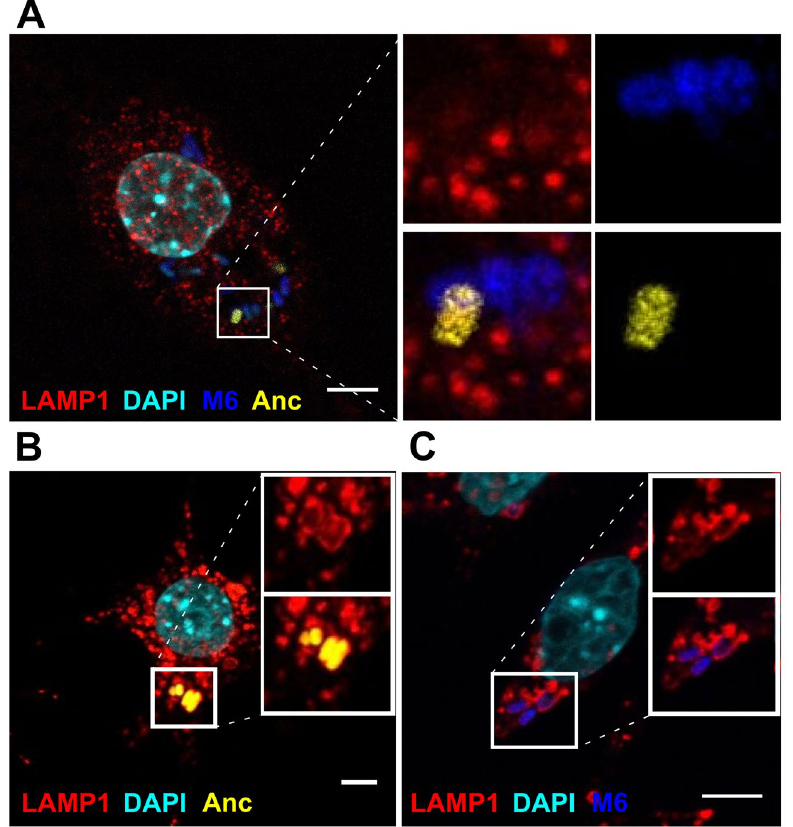
Figure 1. Anc and M6 bacteria-containing phagosomes are negative for the autophagosomal marker LC3 and positive for the late endosomal/lysosomal marker LAMP1. Representative confocal images of infected M Φ s. Anc bacteria are shown in yellow and the M6 evolved clone in blue. Scale bar: 5 µ m. ( A ) M Φ s were infected with a MOI of 20 of Anc and 120 of M6 bacteria. Cells were fixed at 1 h post-infection and stained with α -LC3 antibody (red) and DAPI (cyan). ( B ) M Φ s infected with a MOI of 20 of Anc bacteria at 1 h post-infection, fixed and stained with α -LAMP1 antibody (red) and DAPI (cyan). ( C ) M Φ s infected with a MOI of 120 of M6 bacteria at 1 h post-infection, fixed and stained with α -LAMP1 antibody (red) and DAPI